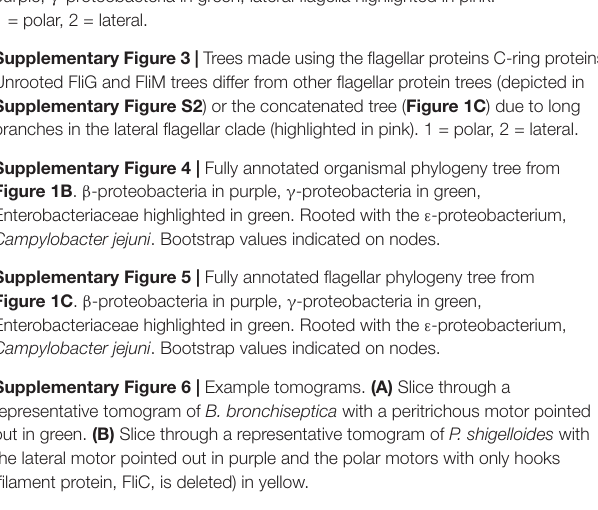
Supplementary Figure 1 | Fully annotated wide-scale flagellar phylogeny tree from Figure 1A . An unrooted, wide-scale tree of flagellar phylogeny. The Enterobacteriaceae ( Salmonella enterica and Escherichia coli) are not clustered with the other γ -proteobacteria (green), but are clustered within the β -proteobacteria (purple). Supplementary Figure 2 | Unrooted trees of individual flagellar proteins. Individual flagellar proteins used in the concatenated flagellar tree have similar topologies with each other and with the concatenated tree. β -proteobacteria in purple, γ -proteobacteria in green, lateral flagella highlighted in pink. 1 = polar, 2 = lateral. Supplementary Figure 3 | Trees made using the flagellar proteins C-ring proteins. Unrooted FliG and FliM trees differ from other flagellar protein trees (depicted in Supplementary Figure S2 ) or the concatenated tree ( Figure 1C ) due to long branches in the lateral flagellar clade (highlighted in pink). 1 = polar, 2 = lateral. Supplementary Figure 4 | Fully annotated organismal phylogeny tree from Figure 1B . β -proteobacteria in purple, γ -proteobacteria in green, Enterobacteriaceae highlighted in green. Rooted with the ε -proteobacterium, Campylobacter jejuni . Bootstrap values indicated on nodes. Supplementary Figure 5 | Fully annotated flagellar phylogeny tree from Figure 1C . β -proteobacteria in purple, γ -proteobacteria in green, Enterobacteriaceae highlighted in green. Rooted with the ε -proteobacterium, Campylobacter jejuni . Bootstrap values indicated on nodes. Supplementary Figure 6 | Example tomograms. (A) Slice through a representative tomogram of B. bronchiseptica with a peritrichous motor pointed out in green. (B) Slice through a representative tomogram of P. shigelloides with the lateral motor pointed out in purple and the polar motors with only hooks (filament protein, FliC, is deleted) in yellow. Supplementary Figure 7 | Subtomogram averages prior to C100 rotational averaging. (A) Slice through Bordetella bronchiseptica motor unsymmetrised subtomogram average, (B) Slice through Plesiomonas shigelloides lateral motor unsymmetrised subtomogram average. Boxes are 100 nm × 100